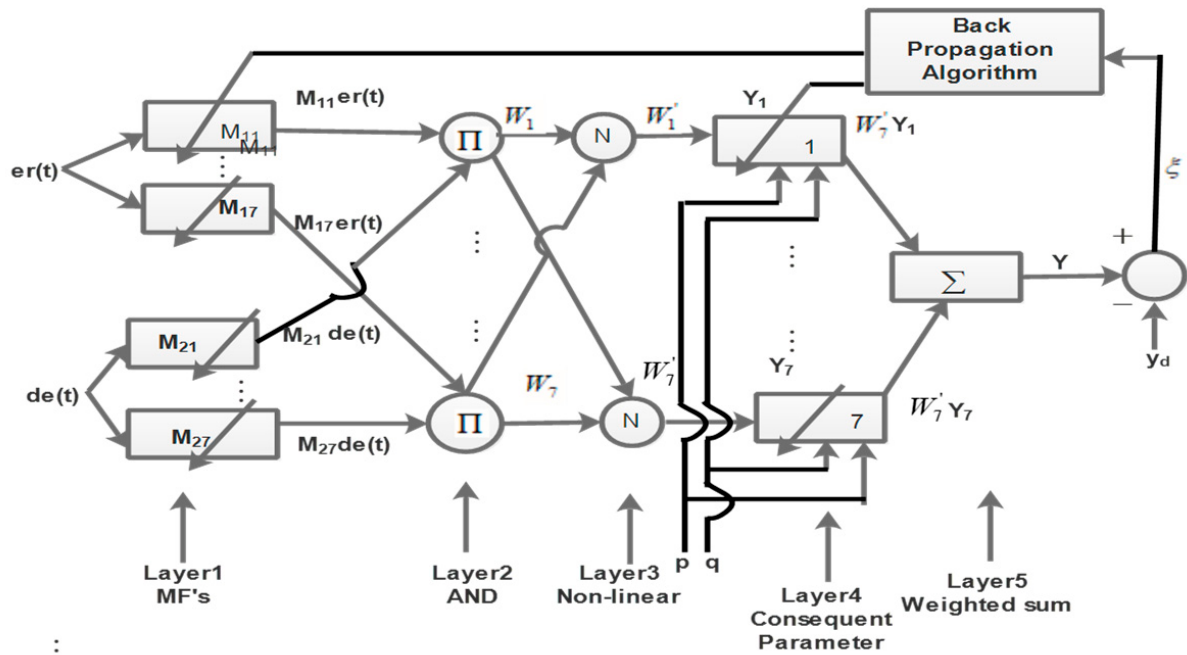
Figure 12. Block diagram of ANFIS controller techniques.